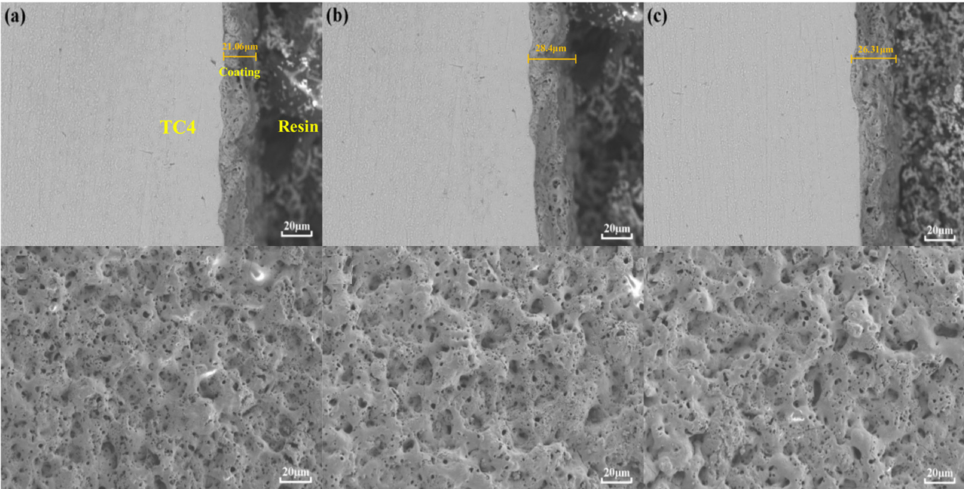
Figure 1. Cross-sectional and surface morphology of MAO layer on TC4 alloy with different additives: